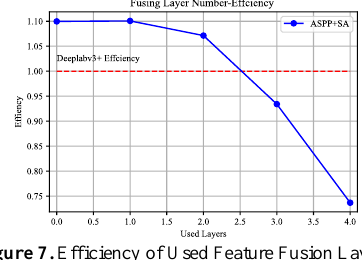
Figure 7. Efficiency of Used Feature Fusion Layers.